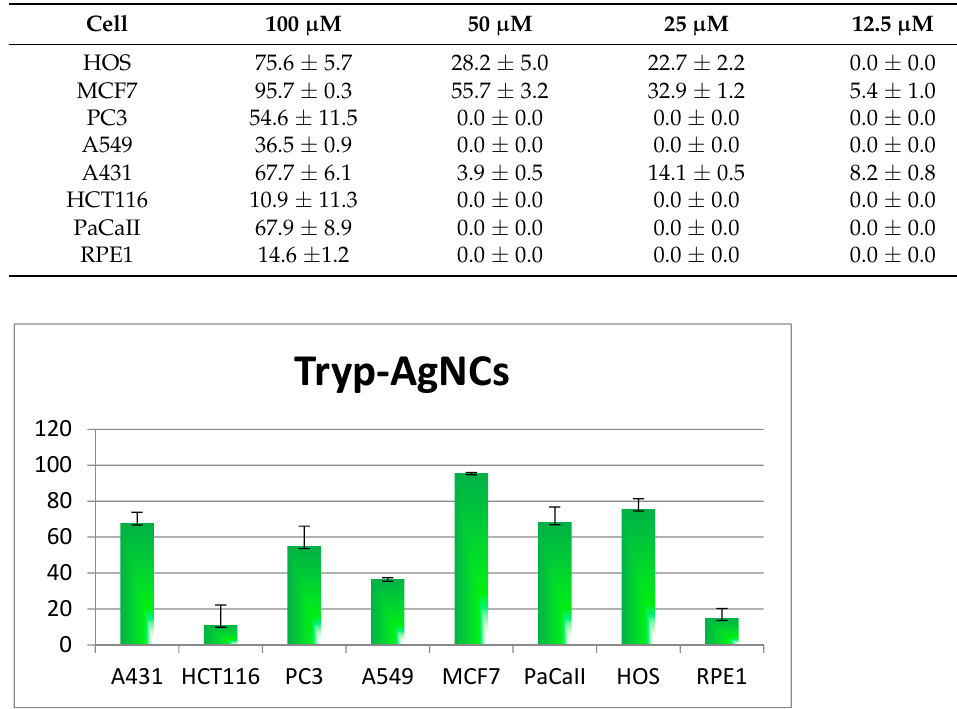
Table 3. The activity of Tryp-AgNCs on tumor cell lines.